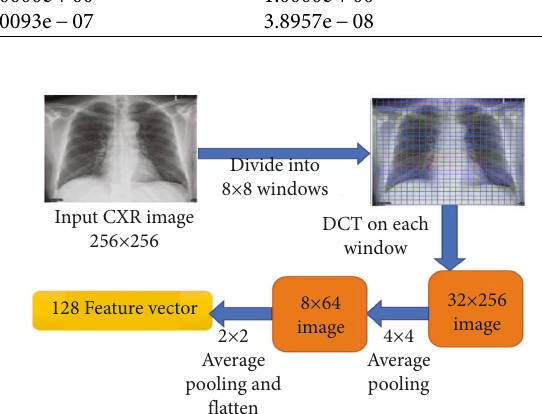
Figure 6: Feature extraction for binary classification.